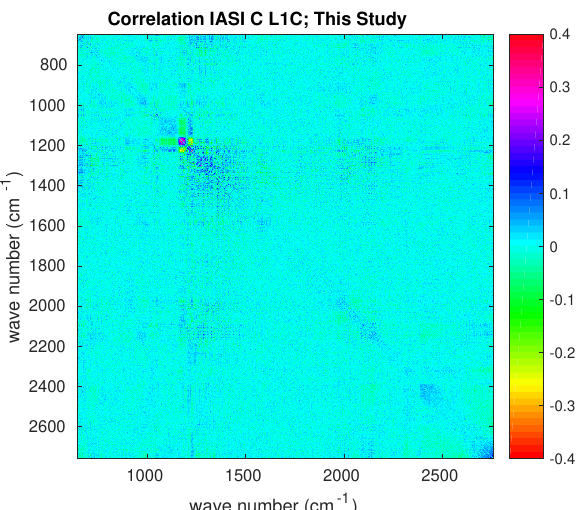
Figure 8. IASI-C S ε transformed to correlation matrix estimated on the basis of Earth-scene views. The diagonal has been subtracted to allow for a better visual inspection for possible correlation patterns. Results have been averaged over the four IASI pixels.